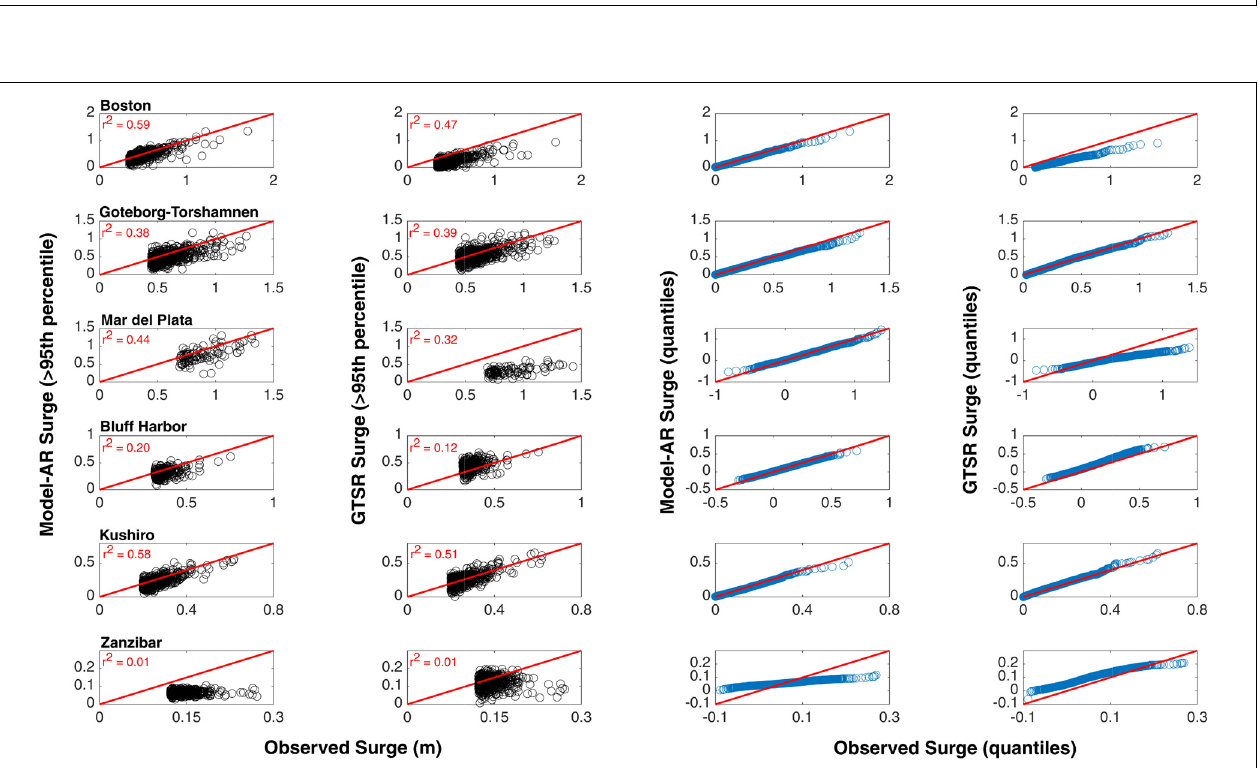
FIGURE 13 | Performance of Model-AR and GTSR (see y -axis labels) for extreme surge events (surge values higher than 95th percentile of observed daily maximum surge) shown as scatterplots (left) and q–q plots (right).